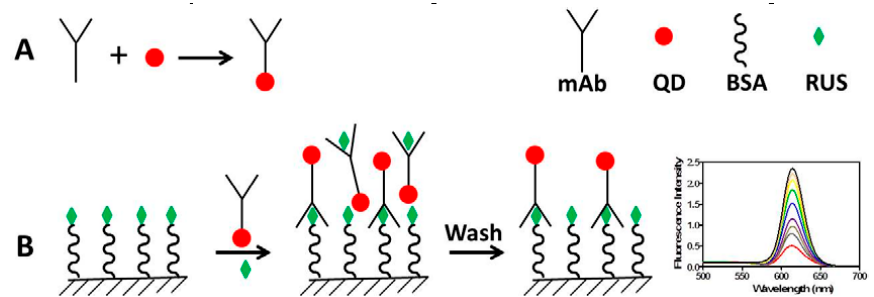
Figure 7. Schematic diagram of cFLISA.